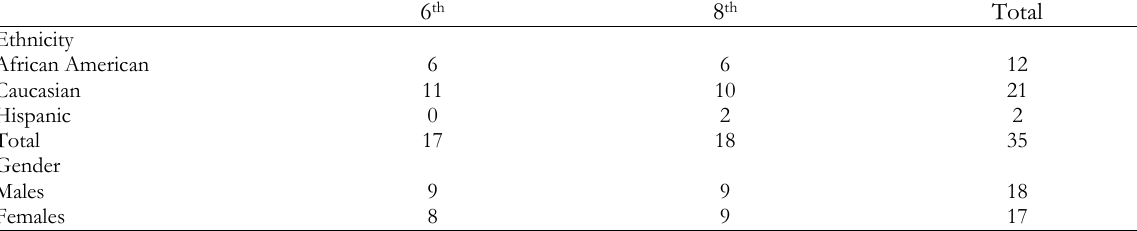
Table 1. Breakdown of sixth and grade students by ethnicity and gender